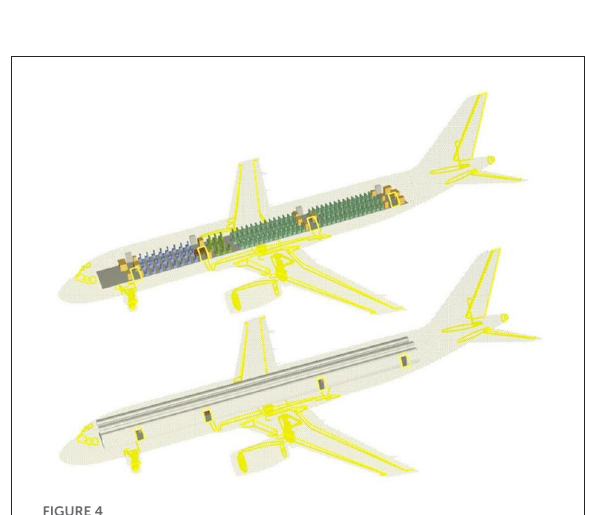
EPUMO2 = 12700 (The energy released per unit mass of oxygen is 12700 kJ/kg) CO_YIELD = 0.012 (The CO generation rate from combustion is 0.012)